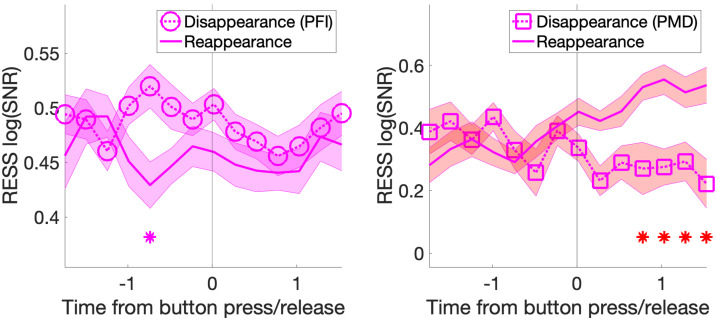
Time course of SNR of the IM (f2-f1: 5-Hz)during PFI and PMD.During PFI, IM-SNR transiently increased prior to disappearance. During PMD periods, IM-SNR increased after target reappearance.
Figure 4—figure supplement 1—source data 1.IM SNR during PFI and PMD.